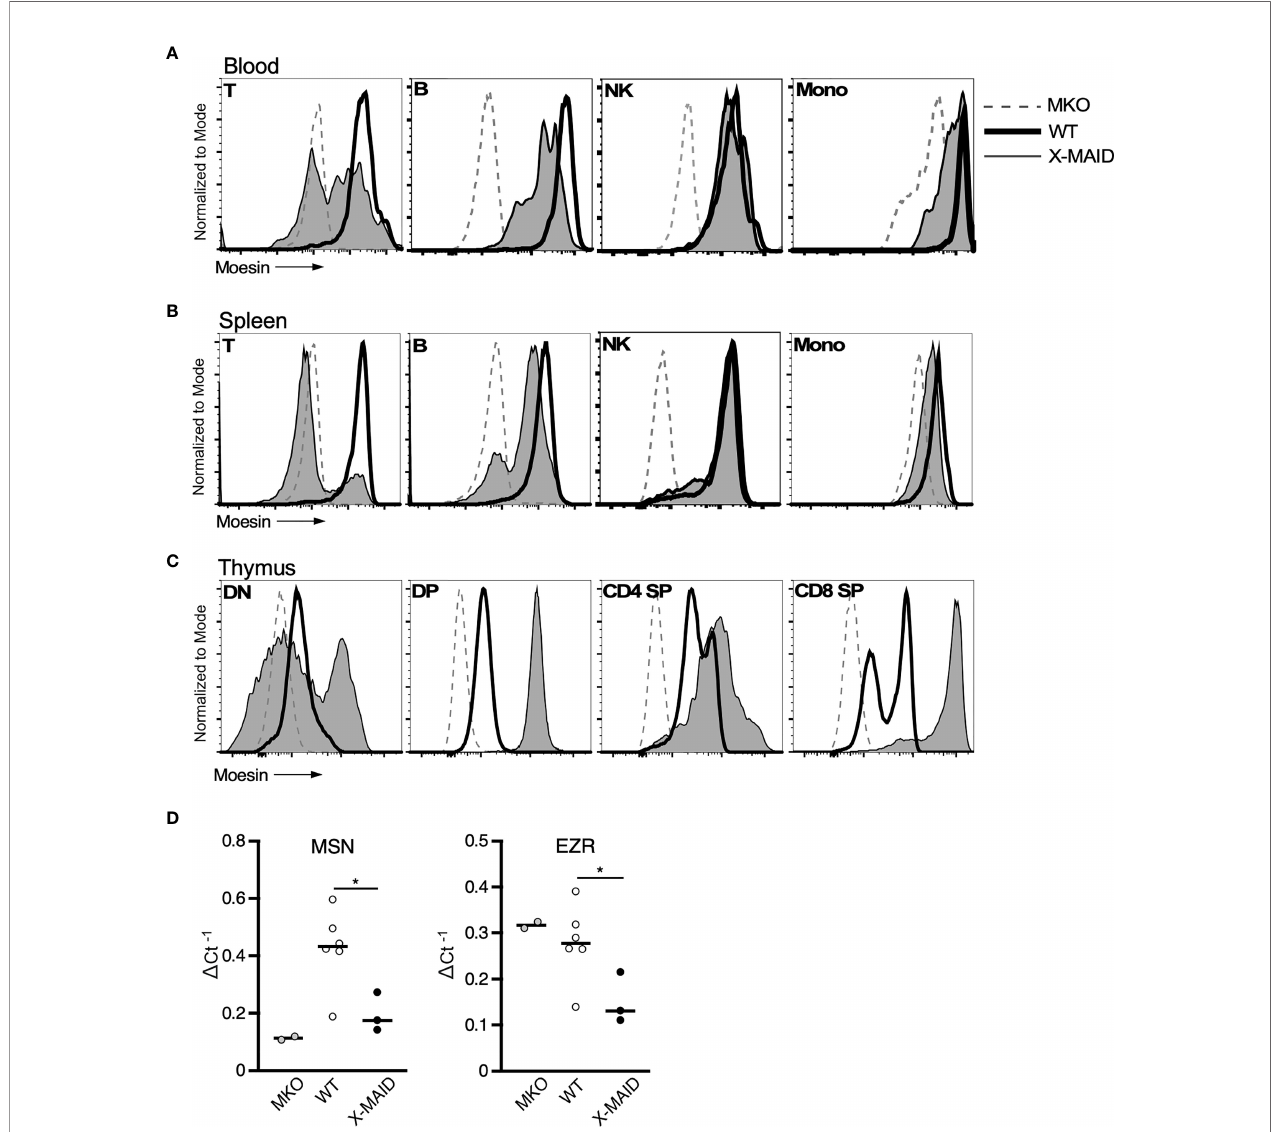
FIGURE 5 | Moesin R171W expression is selectively lost in peripheral T cells. 3-4 week-old WT, X-MAID, or MKO male mice were sacri fi ced and the indicated tissues were harvested and processed for single cell suspensions. Cells were labeled for surface markers, and for intracellular moesin. For blood (A) and spleen (B) , populations were gated on live single cells, followed by TCR b + (T), CD19 + (B), NK1.1 + (NK), and CD11b + Ly6C + (Mono). For thymus (C) , populations were gated on live single cells, followed by CD4 – CD8 – (DN), CD4 + CD8 + (DP), CD4 SP, or CD8 SP. (D) Relative Msn (left) and Ezr (right) mRNA expression in CD4 + splenic T cells from WT, X-MAID, or MKO male mice. Expressed as the inverse of the Ct of indicated gene subtracted from that of Gapdh . Bars in D represent means. Statistics between WT and X-MAID groups were calculated using a Student ’ s t test, *p <